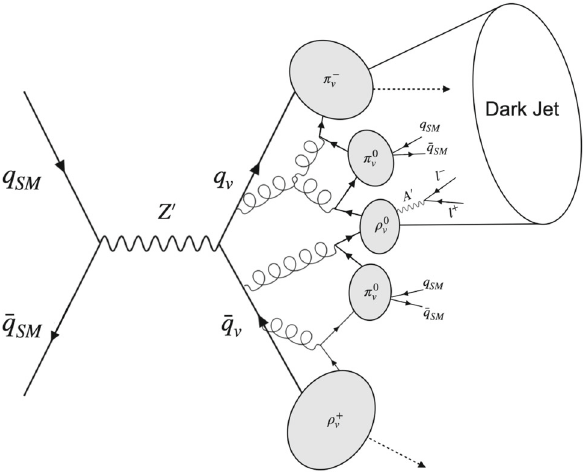
Fig. 1 S-channel production of semi-visible jets with non-isolated prompt leptons produced from dark hadrons decays